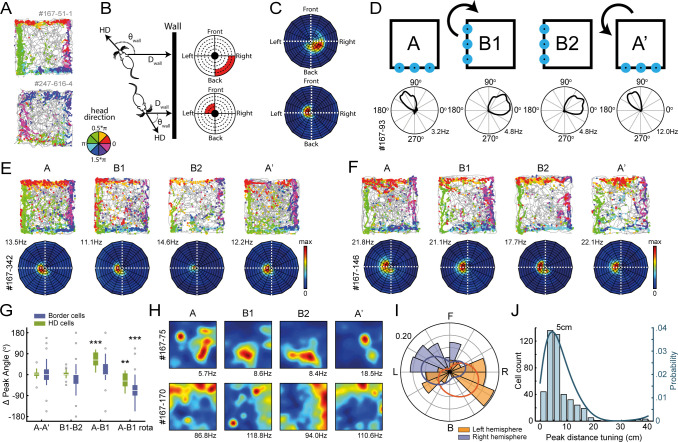
Egocentric tuning of RSC border cells has a hemispheric bias and is invariant to the rotation of place and head-direction signals.(A) Example trajectory spike plots with spike locations color-coded according to the head-direction of the animal. Most spikes alongside a wall occur only when the animal was in a narrow range of directions. Top: recorded in the right hemisphere. Bottom: recorded in the left hemisphere. (B) Trajectory data was projected onto new body-centric border maps, where coordinates indicate the distance (Dwall) and direction (θwall) of the closest wall relative to the animal's position and head-direction (HD), respectively. (C) Rate maps in this border space for the same example cells shown in (A). (D) Top: Blue LEDs were placed as distal cues on one side of the maze, and the entire experimental set-up was rotated 90° clockwise in the middle sessions. Bottom: example allocentric HD cell showing its tuning shifted accordingly. (E-F) Two example border cells with trajectory spike plots and border rate maps showing egocentric border tuning was stable across rotation sessions. (G) Comparison of shifts in direction tuning for allocentric head-direction cells and egocentric border cells across the different sessions, where B1-rota is a rotated version of the rate map in the opposite direction of the physical rotation of the arena, matching the layout again as in A. (H) Two examples of spatially-stable cells, defined as having spatial correlations above the 99th percentile of a time-shuffled distribution, which rotated along with the cue. (I) Preferred directional tuning of all recorded border cells with significant directional tuning, split according to the location of the electrode in either the left or right hemisphere. (J) Preferred distance tuning of all RSC border cells. **p<0.01, ***p<0.001, Wilcoxon signed-rank test.